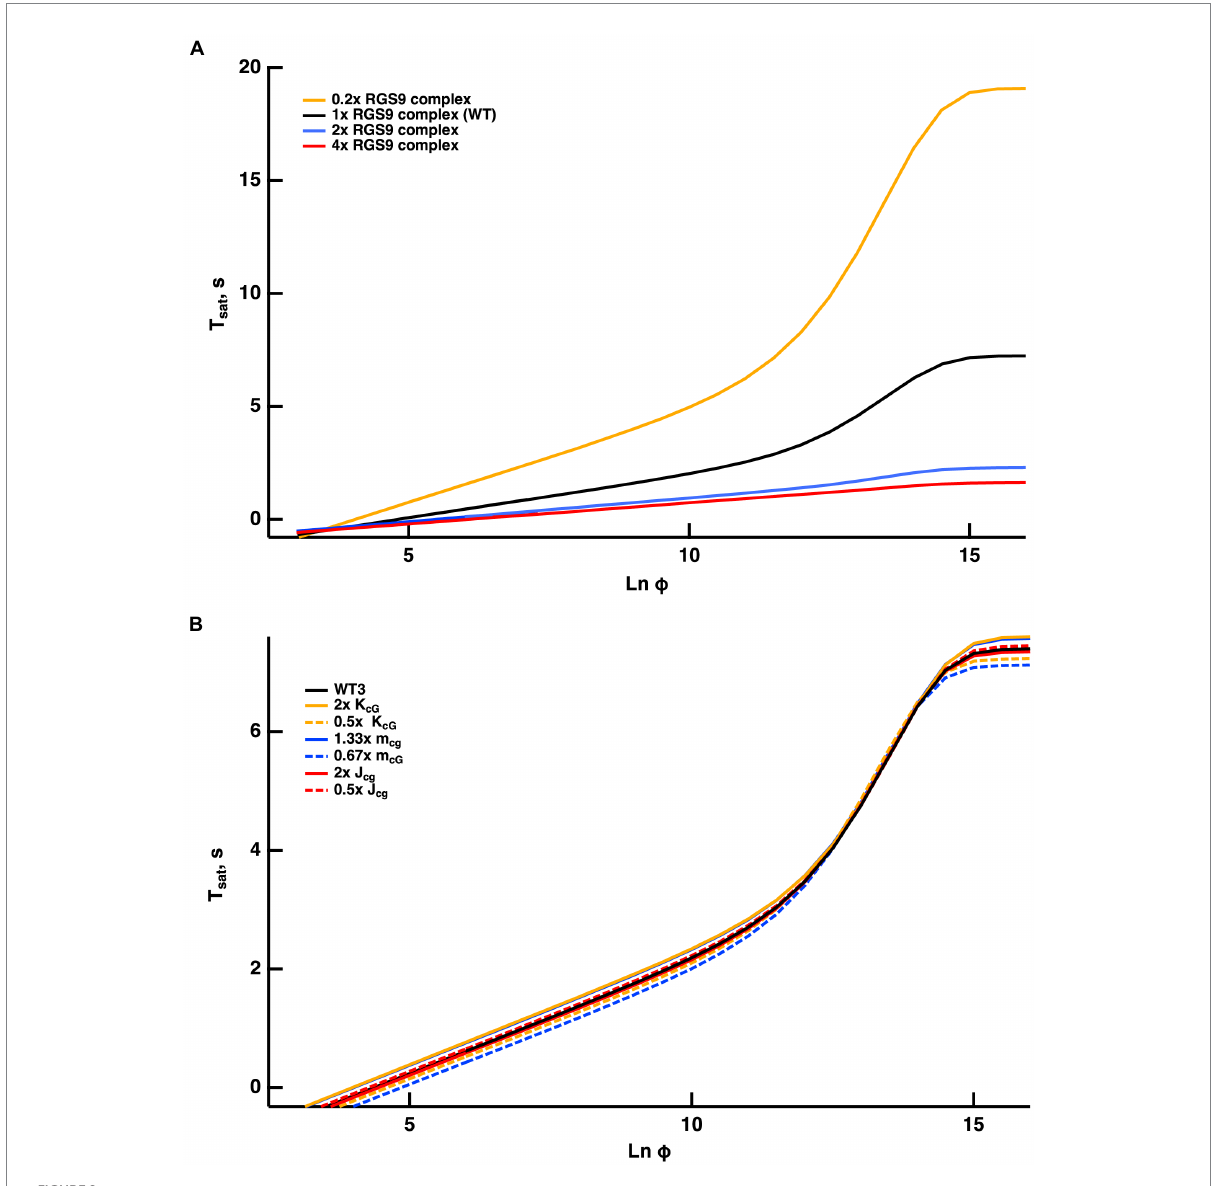
FIGURE 9 Model predictions for Pepperberg relations upon changing T* -- E shutoff (A) or changing rod sensitivity (B) . Curves were generated for T sat measured from mid-flash to 20% recovery. (A) Flash strength dependent deviations from linearity given by the model for various levels of RGS9 complex. (B) Shifts in the X-intercept predicted by the model for changes in sensitivity arising from alterations in the affinity of the CNG channel for cGMP or its cooperativity, or a change in dark